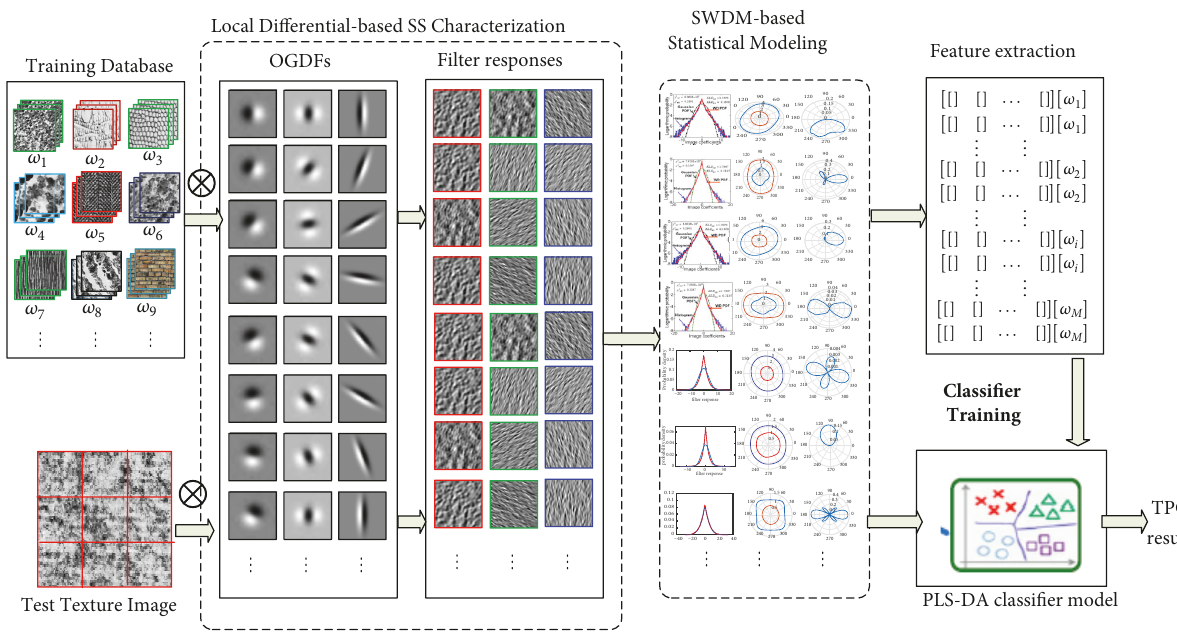
Figure 5: Schematic